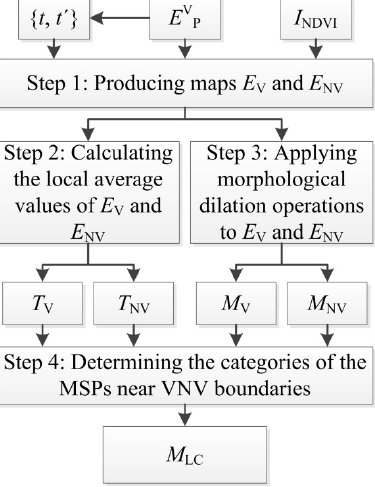
Figure 3. The flow diagram of the classification of the MSPs near VNV boundaries.